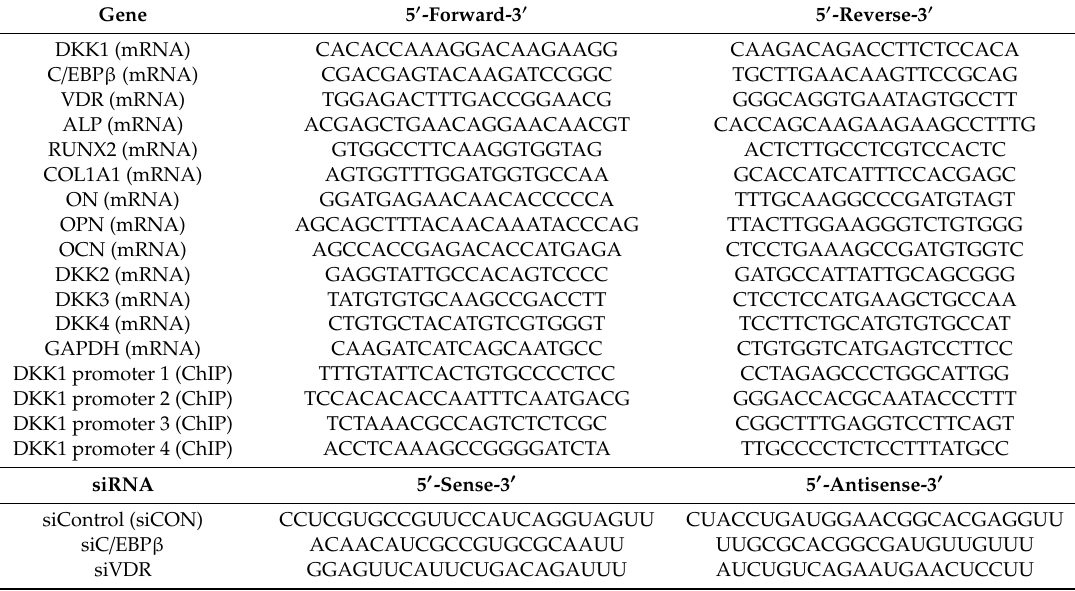
Table 2. Primer sequences for qPCR and ChIP assay and siRNA target sequences.